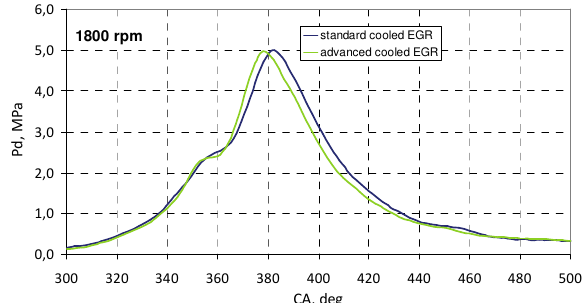
Fig. 24. Impact of EGR cooling system at MBF specific values (engine rotational speed: 1800 rpm, 190 Nm